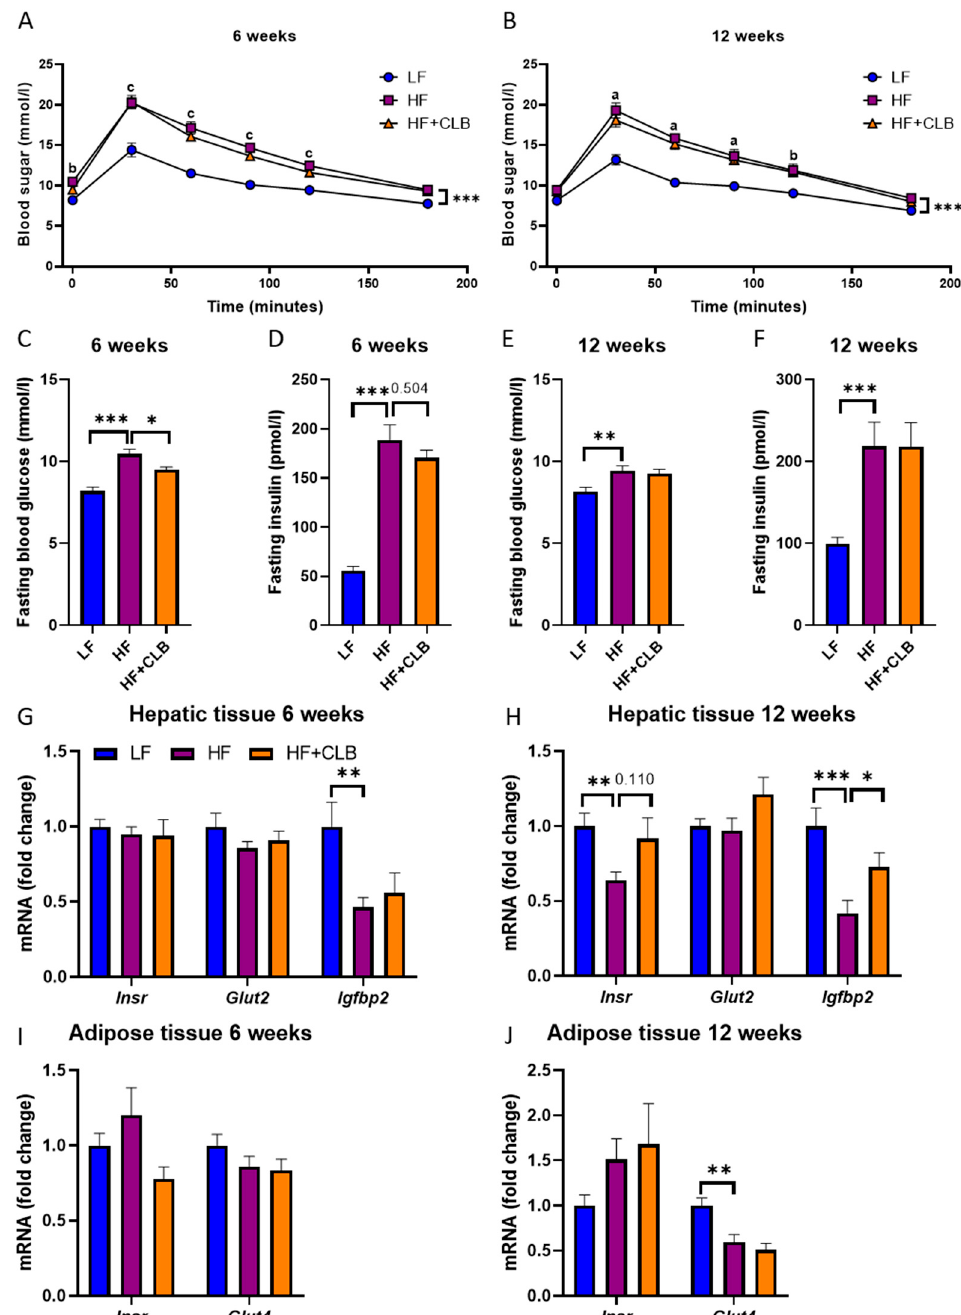
Figure 6. Glucose metabolism. Mice were divided into six groups to receive either a low-fat diet (10% of energy from fat, LF), high-fat diet (46% of energy from fat, HF), or cloudberry-supplemented high-fat diet (HF+CLB) for six ( A , C , D , G , I ) or twelve ( B , E , F , H , J ) weeks. A week before the end of the treatment, the fasting glucose was measured, and an intraperitoneal glucose tolerance test (IPGTT) was performed. The fasting glucose levels and the glucose levels after the glucose bolus (2 mg/g; A , B , C , E ) are expressed as mmol/L. The fasting insulin levels ( D , F ) are expressed as pmol/L. The gene expression of glucose metabolism-related factors in the liver ( G , H ) and in the epididymal adipose tissue ( I , J ) is expressed as fold change relative to the LF group, which was set as 1. The expression levels were measured with RT-PCR and normalized to glyceraldehyde 3-phosphate dehydrogenase ( Gapdh ). The data were analyzed with two-way (mixed model) ANOVA for A and B and with one-way ANOVA for C–J, all with the Bonferroni post-test. The area under the curve (AUC) was calculated using the average of the LF group at 0 min as baseline for testing with one- way ANOVA and Bonferroni post-test. * p < 0.05, ** p < 0.01, and *** p < 0.001. For A and B, the